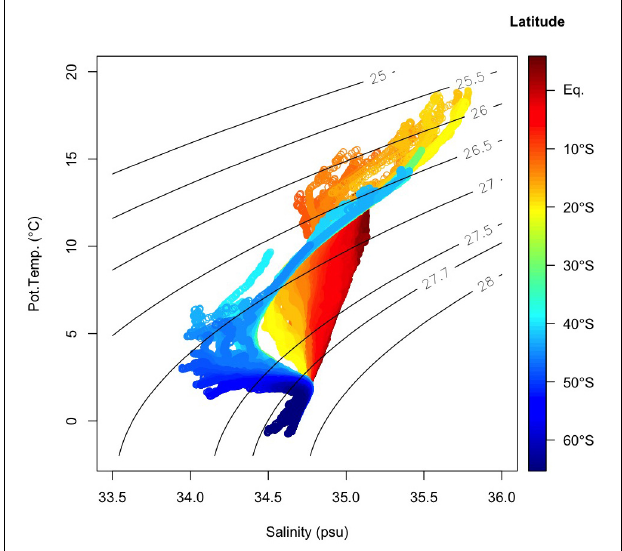
FIGURE 3 | T–S (potential temperature vs. salinity) diagram below 250 m. Color represents the latitude where each sample was collected. Black lines indicate the density surfaces of σ θ